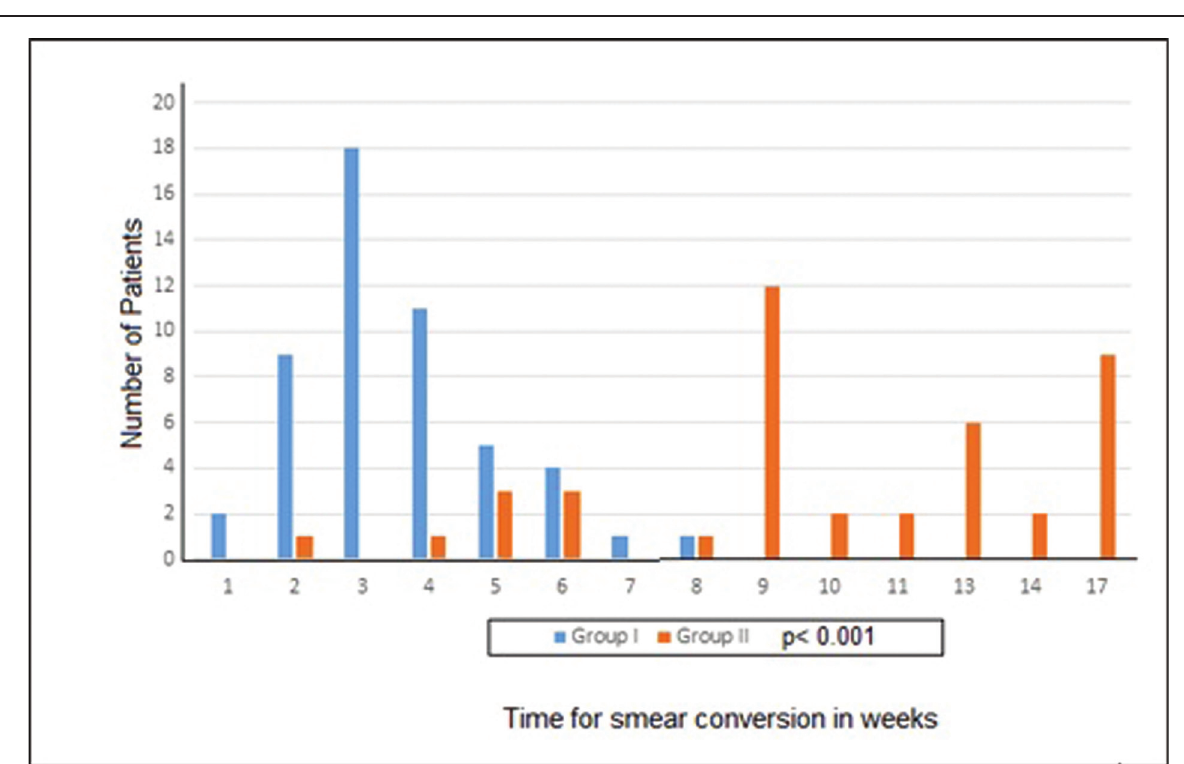
Time for smear conversion in weeks [the median duration of smear conversion for group I was 3 weeks (1 – 8) compared with 9.5 weeks (2 – 17) in group II ( P <